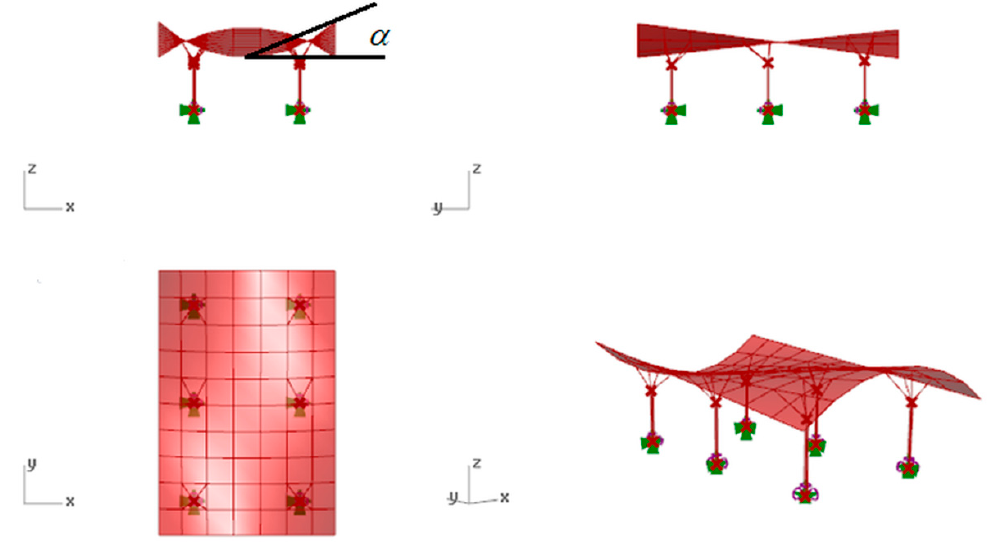
Figure 6. Views of the cylindroid canopy roof - determination of the roof inclination angle.